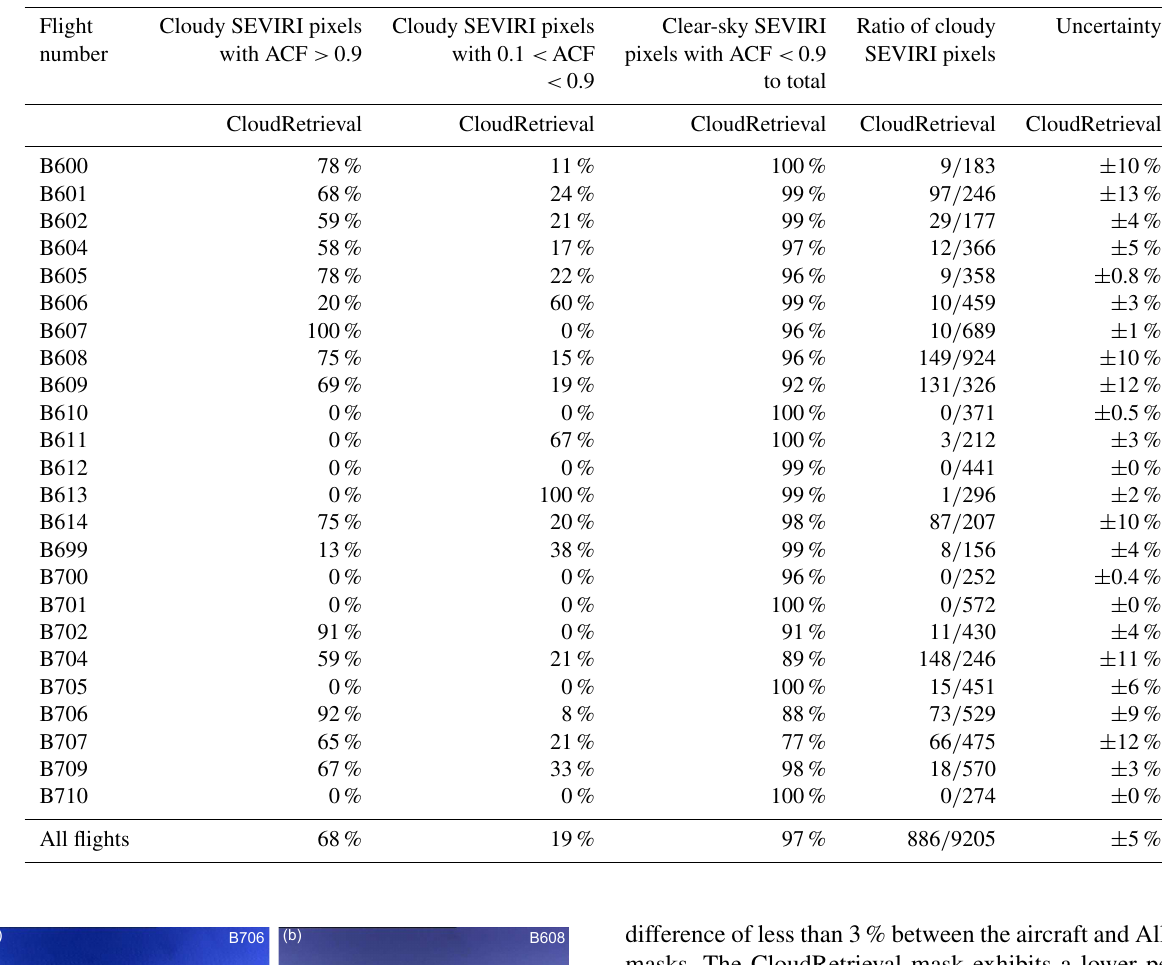
Table 3. As Table 2 but for the CloudRetrieval SEVIRI cloud mask. The ACF range 0.1–0.9 is also shown in this table, as discussed in Sect. 4.